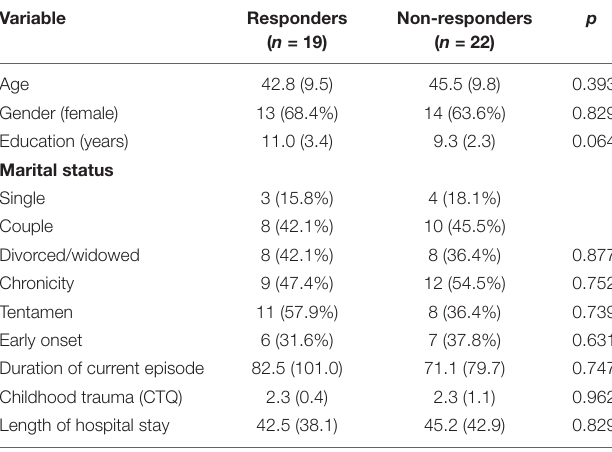
TABLE 1 | Demographic and clinical characteristics of the